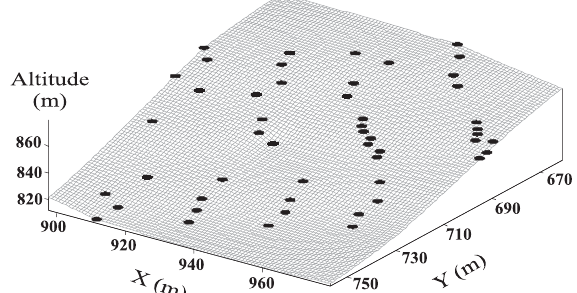
Figura 1. Modelo digital de elevação (MDE) da área em estudo com a distribuição dos pontos